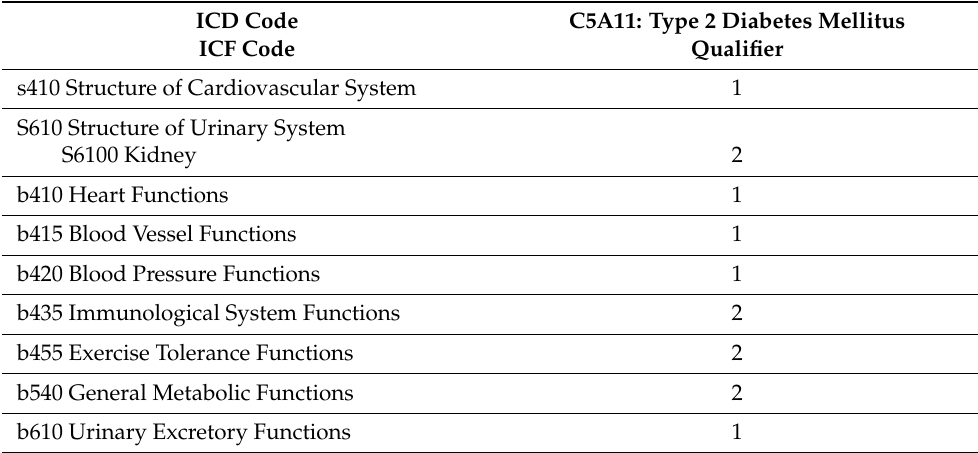
Table 2. ICD code and ICF codes and qualifiers describing the health condition of